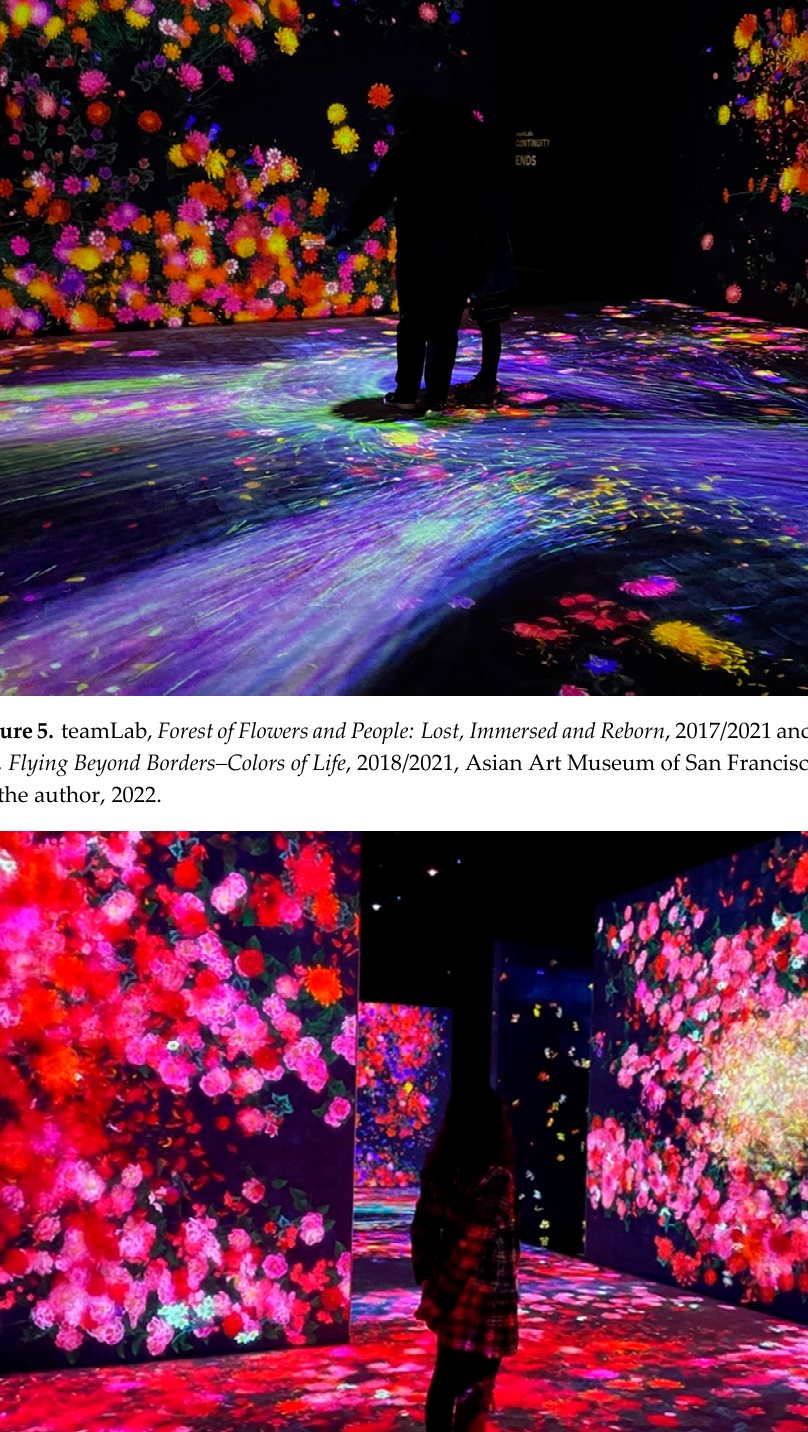
Figure 7. teamLab, Forest of Flowers and People: Lost, Immersed and Reborn (Winter), 2017/2021, Asian Art Museum of San Francisco; photograph by the author, 2022.